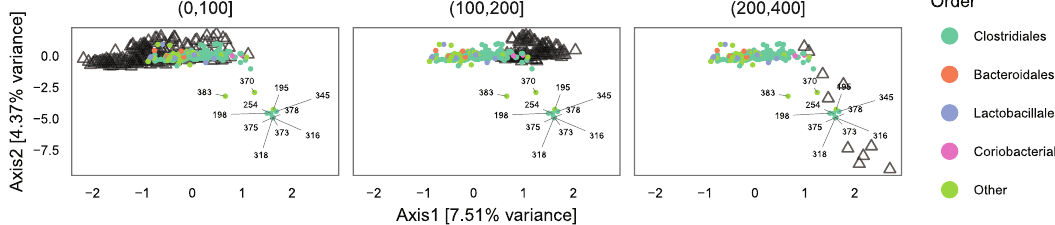
Figure 17. The mouse and bacteria scores generated by CCpnA. The sites and species are triangles and circles, respectively. The separate panels indicate different age groups .